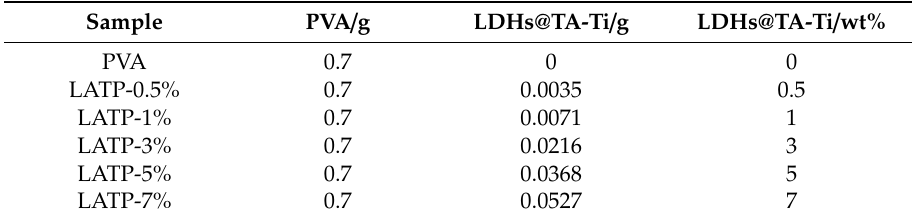
Table 1. The composition and naming of LDHs@TA-T i / PVA nanocomposites. Sample PVA /